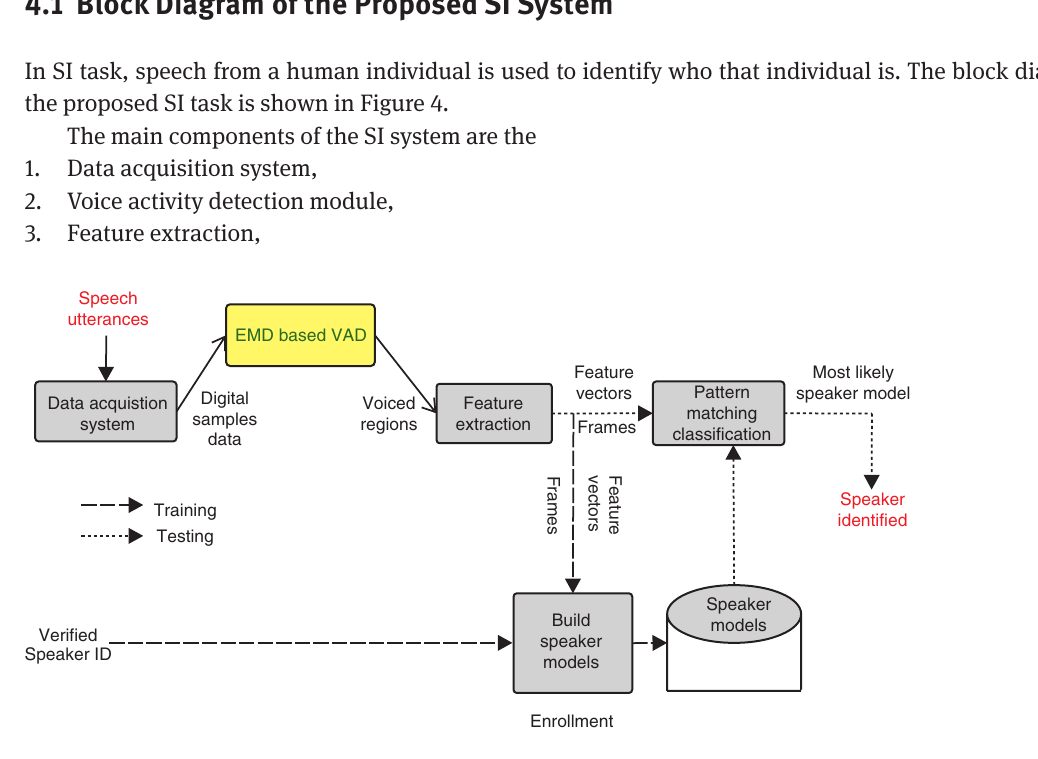
Figure 4. Block Diagram of a Proposed Speaker Identification System